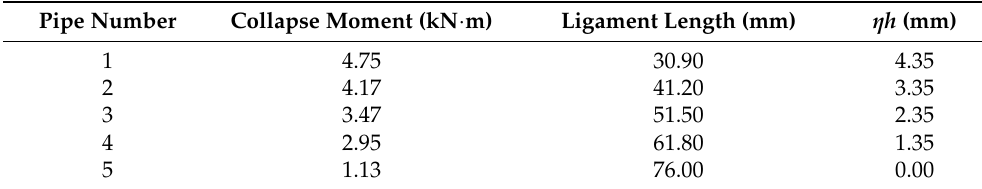
Table 1. Calculated collapse moment and geometry values for the ligament area.